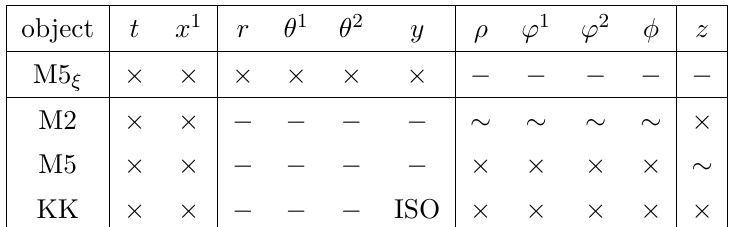
-BPS brane setup of defect M2–M5 branes at a conical singularity intersecting orthogonal Table 6 . 1 8 M5 branes with KK monopoles. This background describes the supergravity dual of N = (0 , 4) a ξ surface defect within the 6d N = (1 , 0) SCFT dual to AdS By further redefining things s.t. f (0) = 1 , H ζ ≡ (cid:0) ρ 2 + z 2 (cid:1) 1 / 2 . Hence, when approaching the origin, the metric in (4.6) exactly